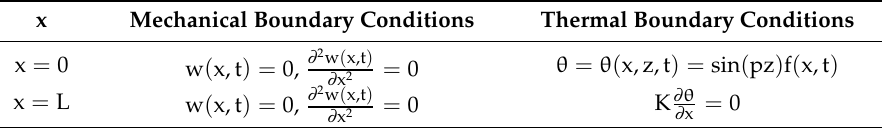
Table 1. The boundary conditions of the